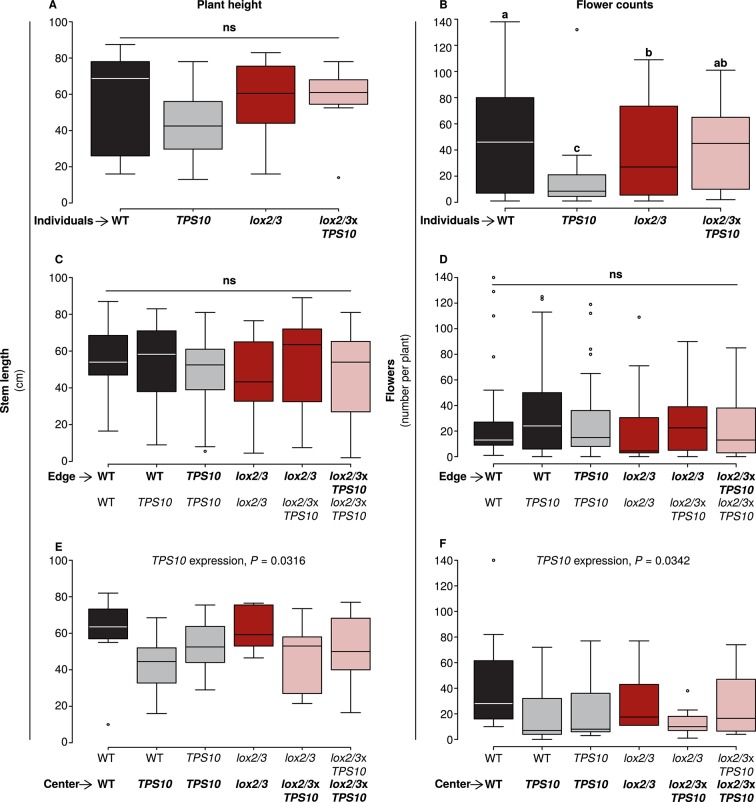
TPS10 expression reduced flower production under high herbivory.Plant size as measured by stem length (left panels), and reproduction as measured by flower production (right panels); n given in Figure 8—source data 1. Data were collected on June 6th in season two from plants at all different positions in the experiment: individual plants (A–B), and plants at the edges (C–D) or at the centers (E–F) of populations. Black bars denote WT, grey bars TPS10, red bars lox2/3, and pink bars lox2/3xTPS10 plants. Plant height differed little, with only a small negative effect of TPS10 expression for center plants (E), which was more pronounced in mixed- than monocultures, indicating a slight competitive disadvantage for these plants. Individual plants differed much more than plants in populations in terms of flower production, with TPS10-expressing plants at a disadvantage (B); this effect was greatly reduced in populations.a,b Different letters indicate significant differences (corrected p<0.05) in Tukey post-hoc tests on plant genotype following significant effects in a generalized linear model, or generalized linear mixed-effects model (C–D) with genotype as a factor; these p-values were corrected using the Holm-Bonferroni correction for multiple testing as the same data were also tested for effects of LOX2/3 deficiency and TPS10 expression (see Figure 8—source data 1). There was no difference in flower production for edge plants, but a small negative effect of TPS10 expression on flower production in center plants (F) corresponding to the slight reduction in height of these plants (E). Statistical models are given in Figure 8—source data 1.DOI:
http://dx.doi.org/10.7554/eLife.04490.02010.7554/eLife.04490.021Figure 8—source data 1.The same statistical approach described in Appendix 3 for Figure 5 was used for plant size and reproduction data from May 17th in season 1, and June 6th in season two (the most complete measurements, closest to the date of herbivore damage screens, from each season).It should be kept in mind that plants in the season one analysis were at an earlier stage of growth and flowering, for example, had about 10% as many flowers as plants in the season 2 analysis; for an analysis of flowering at similar stages, see Figure 7. Significant p-values and factors are given in bold, while p-values and factors marked in grey and in bold are marginal, but are required in the minimal model because their removal resulted in poorer (higher) AIC values. Other non-significant factors remained in models because they were the least insignificant factor (if only one factor remained), or because they are dependent on other factors which are significant or required.